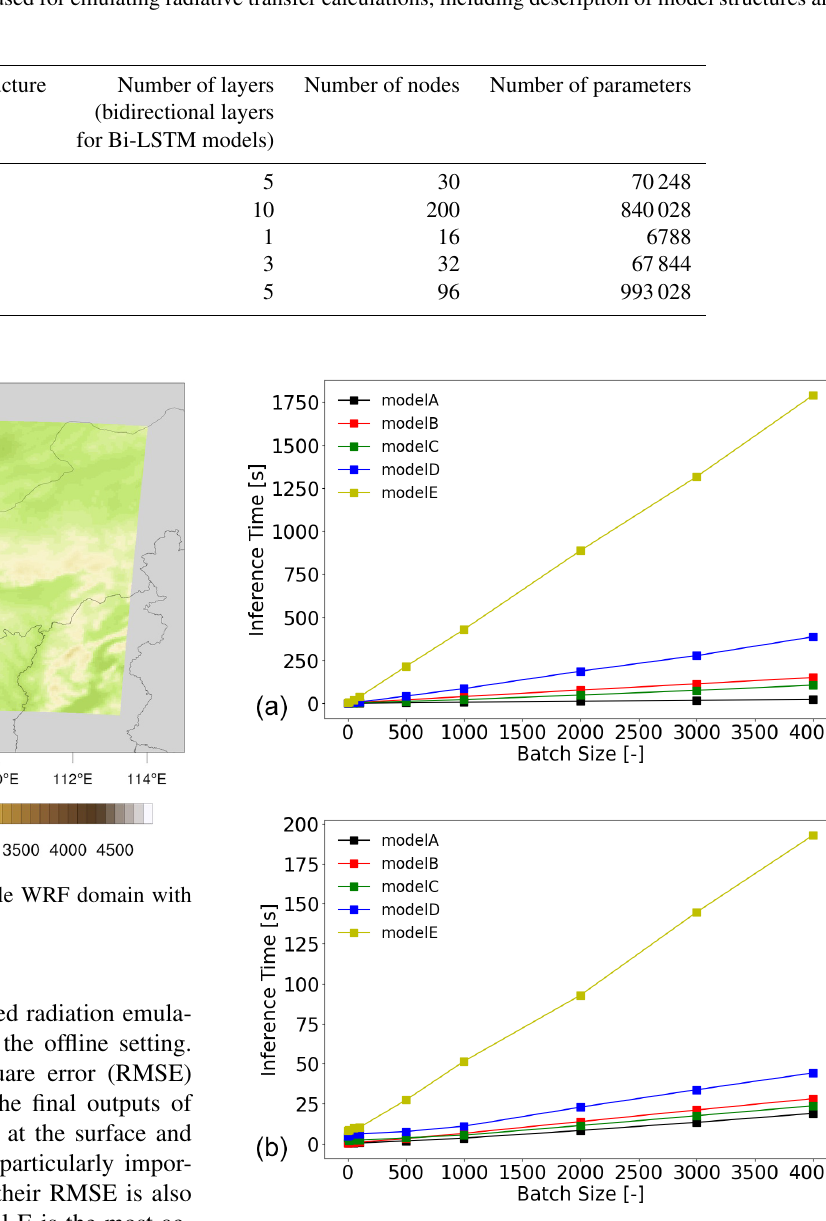
Figure 6. Inference time of different ML-based emulators run on one CPU core (a) and GPU (b) with different batch sizes. The num- ber of vertical levels is